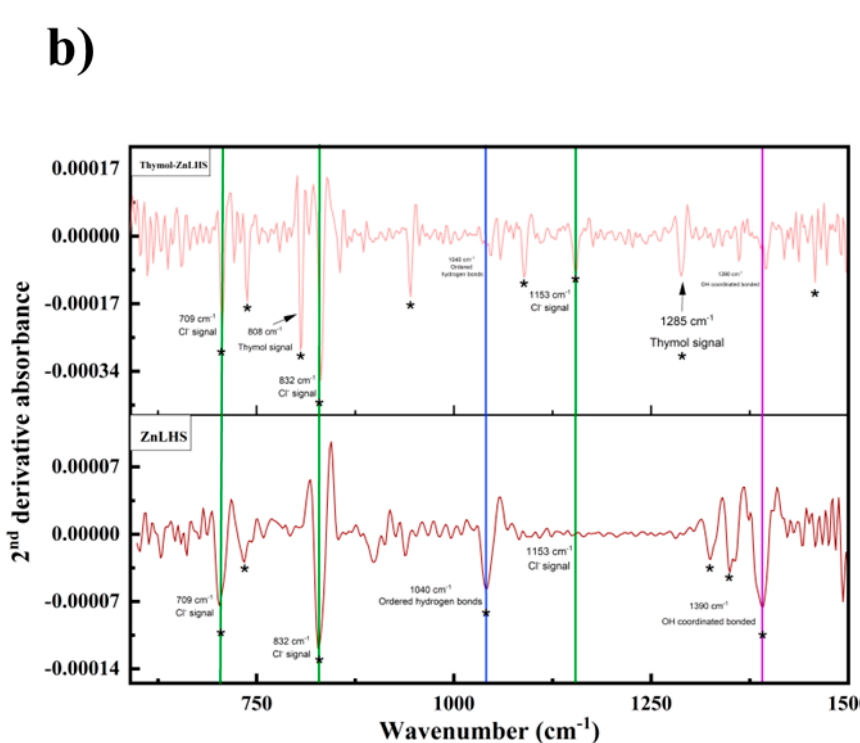
Figure 4. Fourier-transform infrared spectroscopy: ( a ) IR spectra of thymol and zinc layered hy- droxide with and without thymol and ( b ) second derivative spectra of the analyzed samples in the 1500–600 cm − 1 region; significant peaks were considered at p < 0.05 and represented by